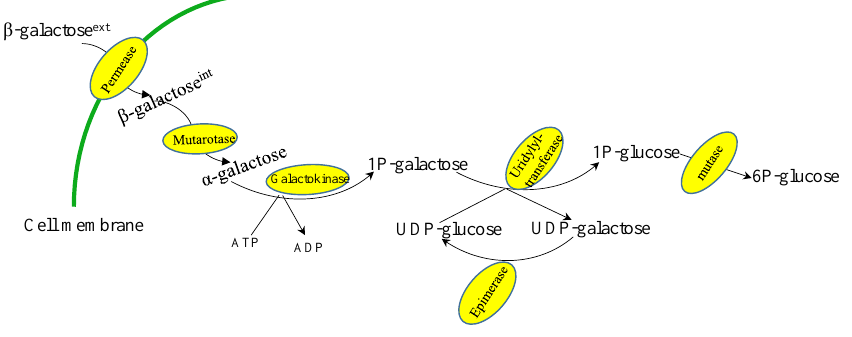
Figure 3. The Leloir pathway of D -galactose catabolism. Unlike K. lactis , S. cerevisiae lacks the gene for β -galactosidase synthesis, although some S. cerevisiae strains can secrete intracellular α -galactosidase, encoded by the MEL1 gene. These S. cerevisiae strains can thus utilize melibiose as a sole carbon source [69,70]. In S. cerevisiae and K. lactis , galactose is catabolized through the Leloir pathway, which includes a four-step enzymatic reaction [64,65]. In S. cerevisiae , the galactokinase Gal1 mediates the initial phosphorylation of galactose in an ATP-dependent manner, resulting in galactose- 1-phosphate. Then, uridine diphosphoglucose 4-epimerase (Gal10) exchanges glucose in UDP-glucose with the phosphorylated galactose, thereby generating